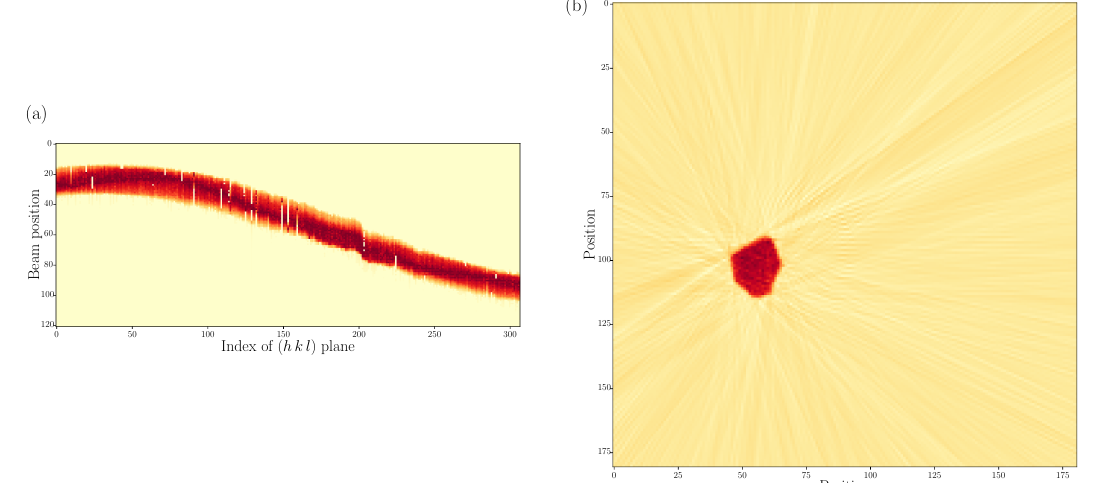
Figure 3. ( a ) Sinogram of one tin grain: The sinogram shows the sum of the intensities of all diffraction peaks belonging to the specific grain as a function of the diffracting lattice planes and the beam coordinate, y . The rows of the sinogram are normalised by the maximum intensity at each beam position. ( b ) Grain shape and position for one grain reconstructed by the inverse Radon transform of the